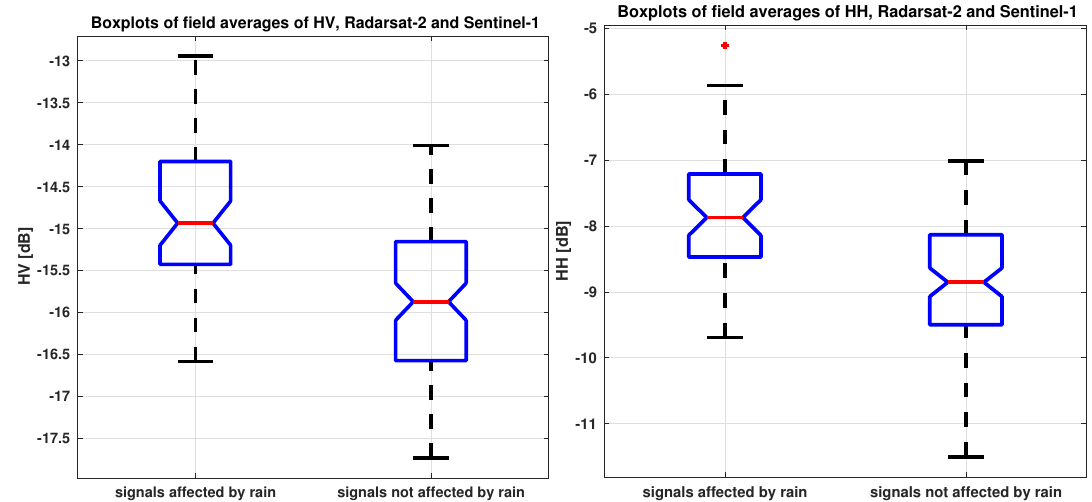
Figure 11. Box plots of RS2 and S1 HV ( left ) and HH ( right ) signals combined over sugarcane fields after their saturation points, showing the effect of rain events on the signal. Central (red) line indicates the median, and bottom and top box edges represent the 25th and 75th percentiles, respectively. Whiskers spanning to the most extreme data points were not considered outliers, and cover approximately 99% of the values. Notches represent the 95% confidence intervals of the